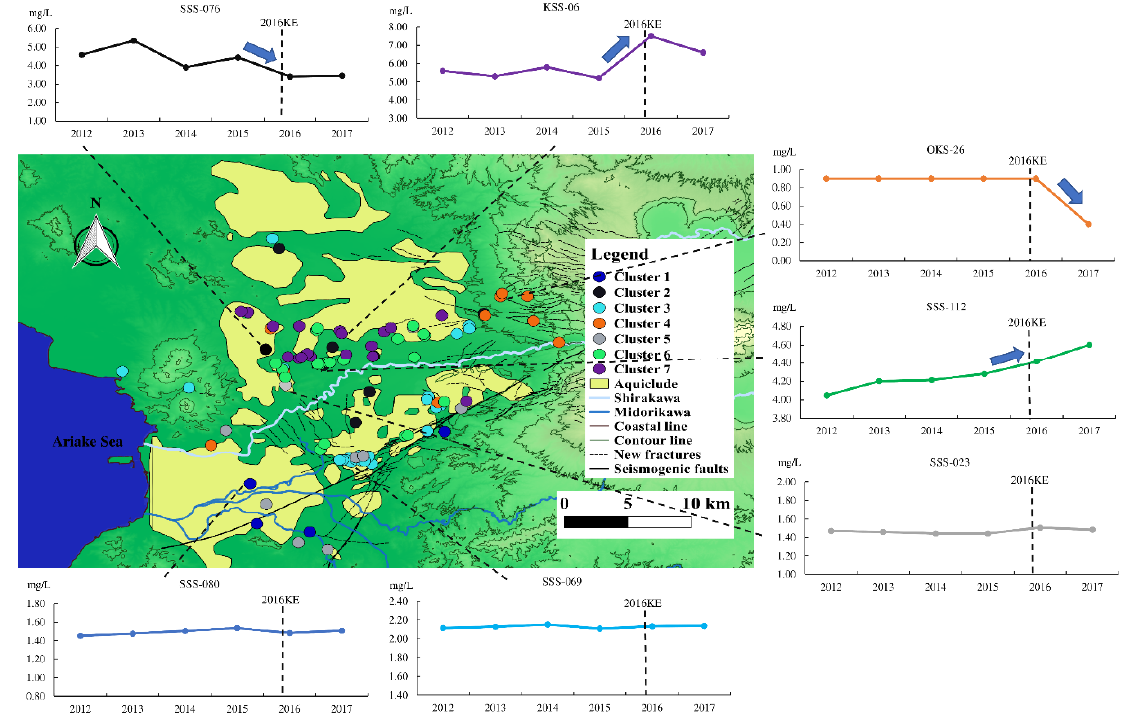
Figure 7. Groundwater nitrate concentration changes in representative wells.